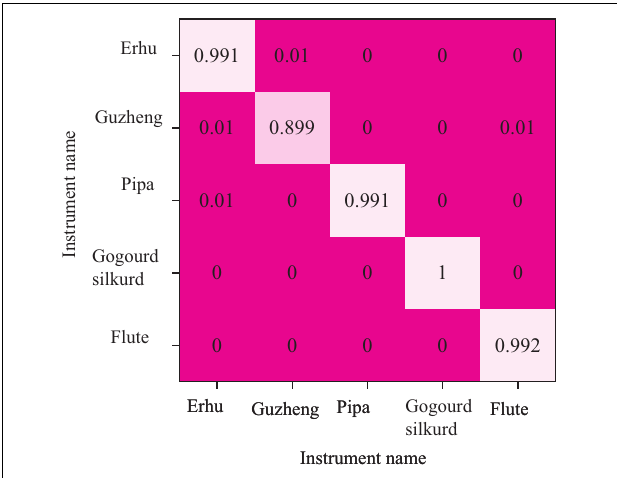
FIGURE 12 | The confusion matrix of recognition accuracy of the DBN and softmax in distinguishing the national musical